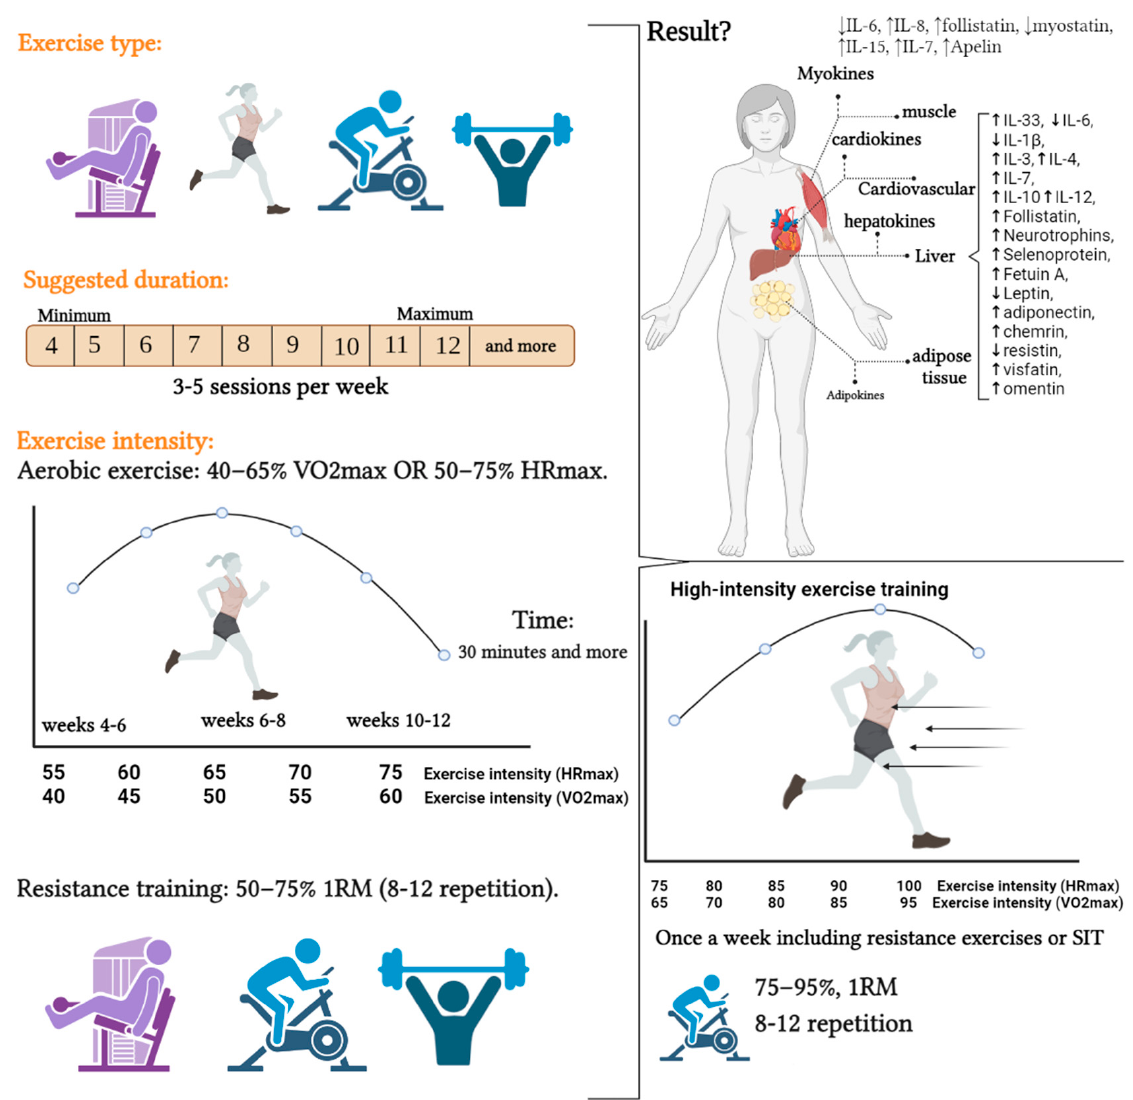
Figure 4. The effect of different type of exercise training on exerkines in women for